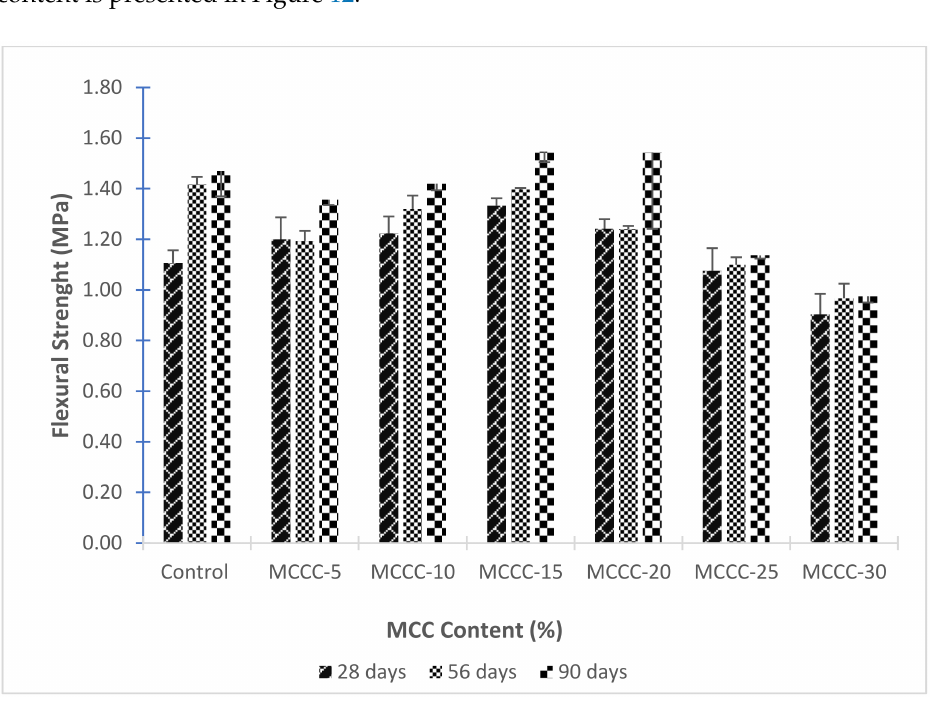
Figure 12. Flexural strength of HPCs at different treatment conditions with